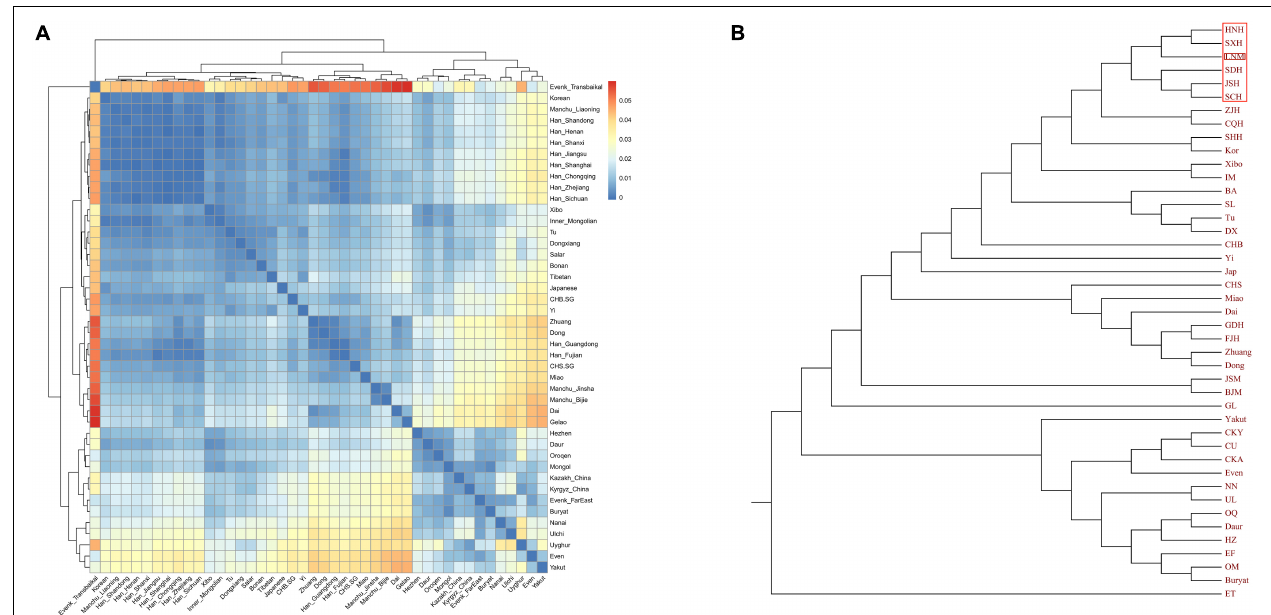
FIGURE 4 | Results of pairwise F ST among East Asian populations. The dark blue color in panel (A) reveals a close genetic distance between two different populations, and panel (B) displays the phylogenetic tree based on F ST values.